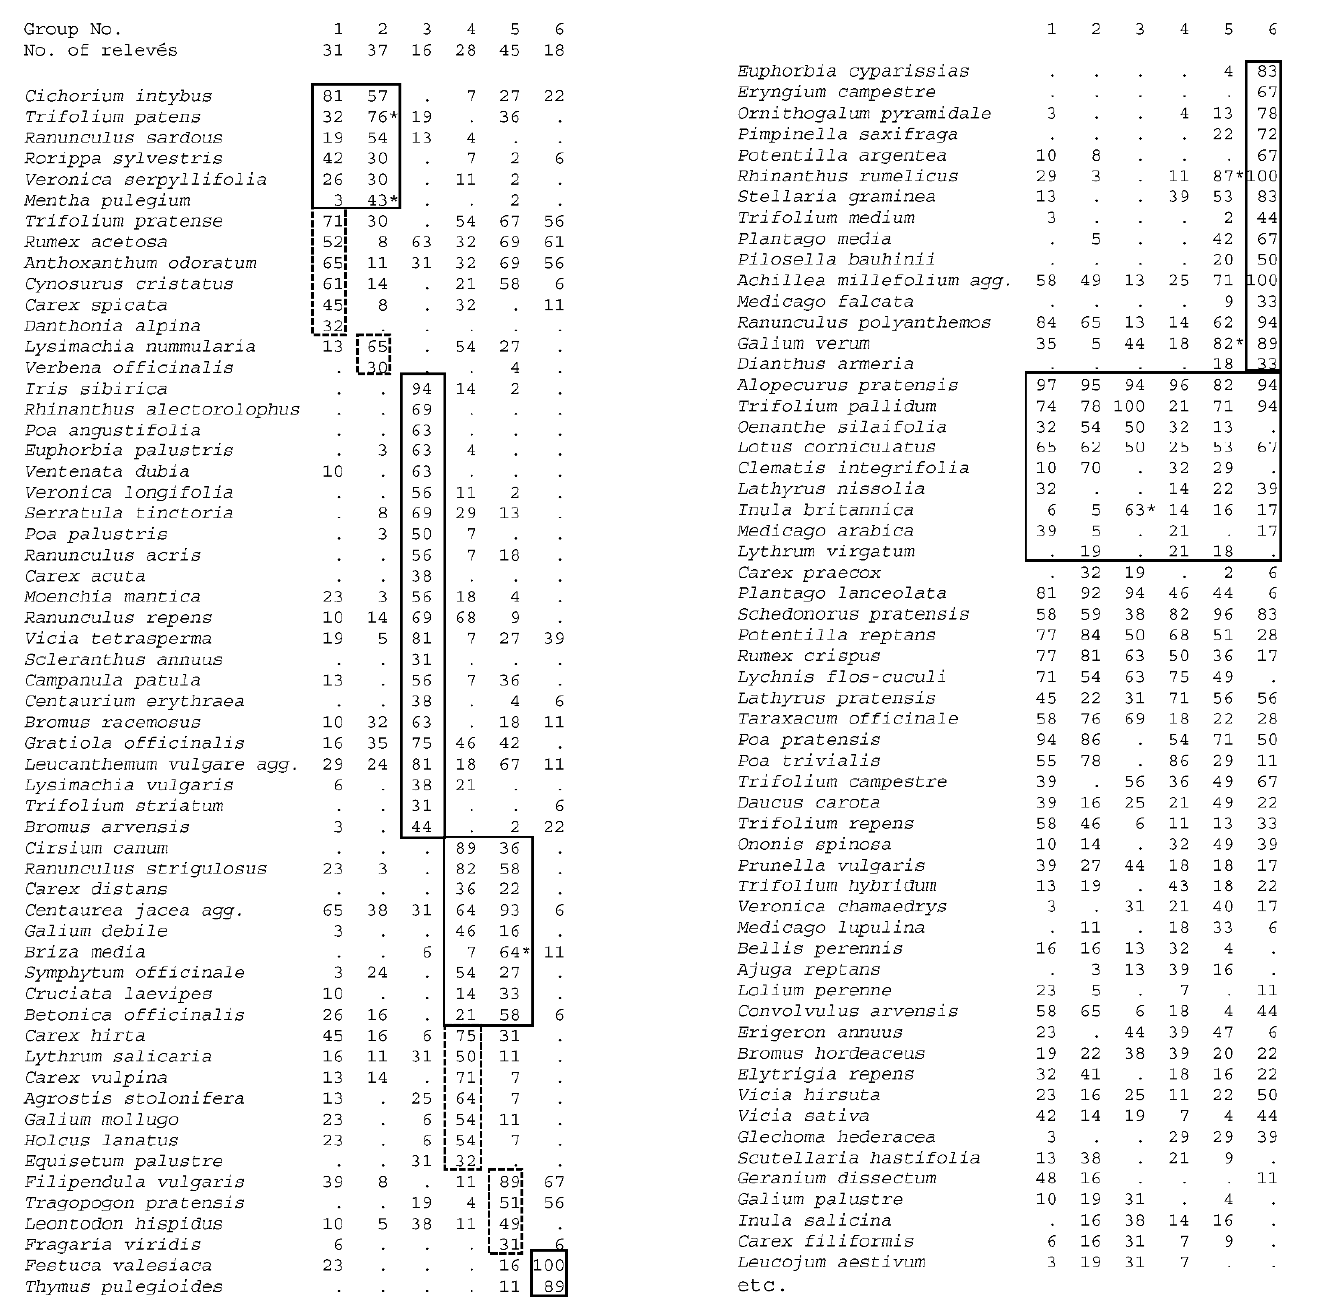
Figure A3. Percentage synoptic table of the Trifolion pallidi meadows. Diagnostic species of syntaxa are framed or indicated by asterisk. Diagnostic species of the Trifolion pallidi and Trifolio–Hordeetalia are from literature. Legend to columns: 1— Trifolio pallidi – Alopecuretum rhinanthetosum rumelici , 2— Trifolio pallidi – Alopecuretum typicum , 3— Ventenato–Trifolietum pallidi , 4— Ranunculo acris–Alopecuretum typicum , 5— Ranunculo acris–Alopecuretum filipenduletosum , 6— Ornithogalo pyramidale – Trifolietum pallidi.